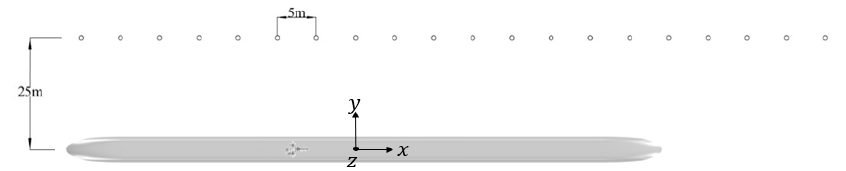
Figure 11. Locations of the standard sound monitoring points along the x-direction.